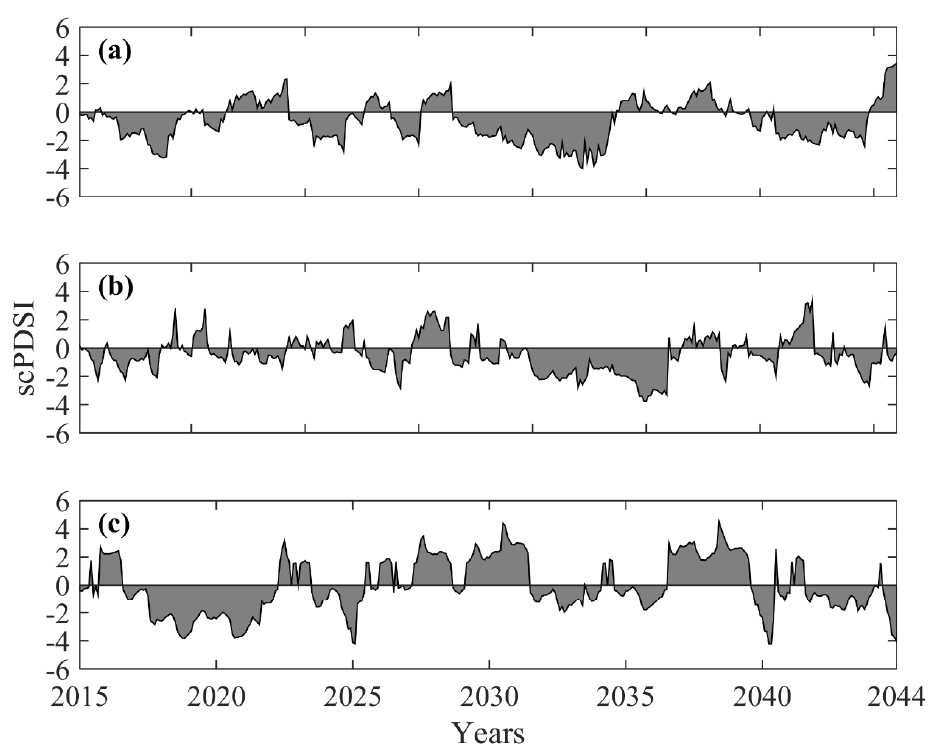
Figure 7. Grid-averaged self-calibrating Palmer Drought Severity Index (scPDSI) values from 2015–2044 for study area AV. ( a ) scPDSI values for SSP1-2.6; ( b ) scPDSI values for SSP2-4.5; ( c ) scPDSI values for SSP5-8.5.